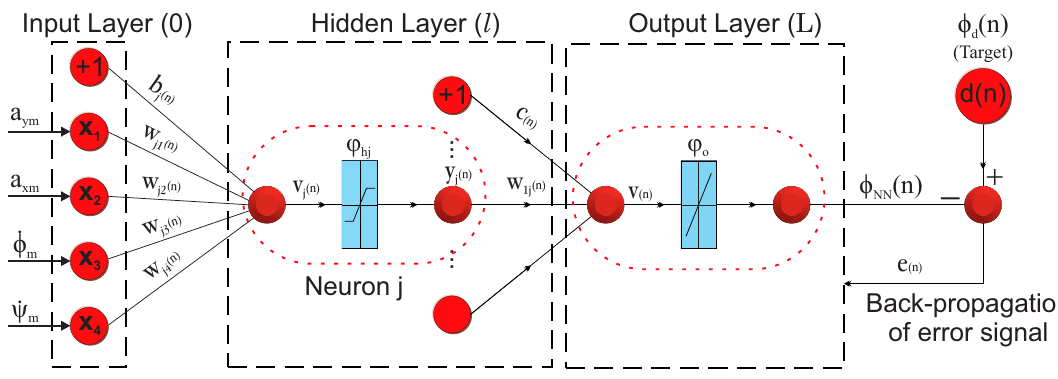
Figure 2. Neural network